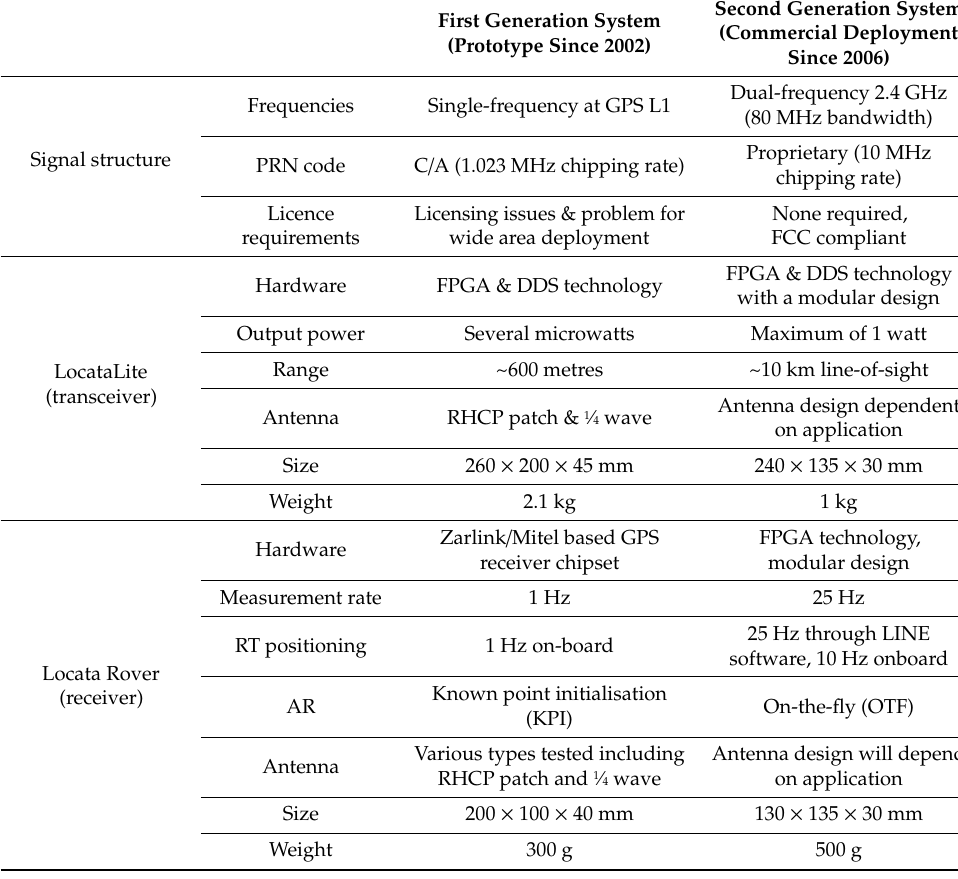
Table 1. Specification summary of Locata’s systems